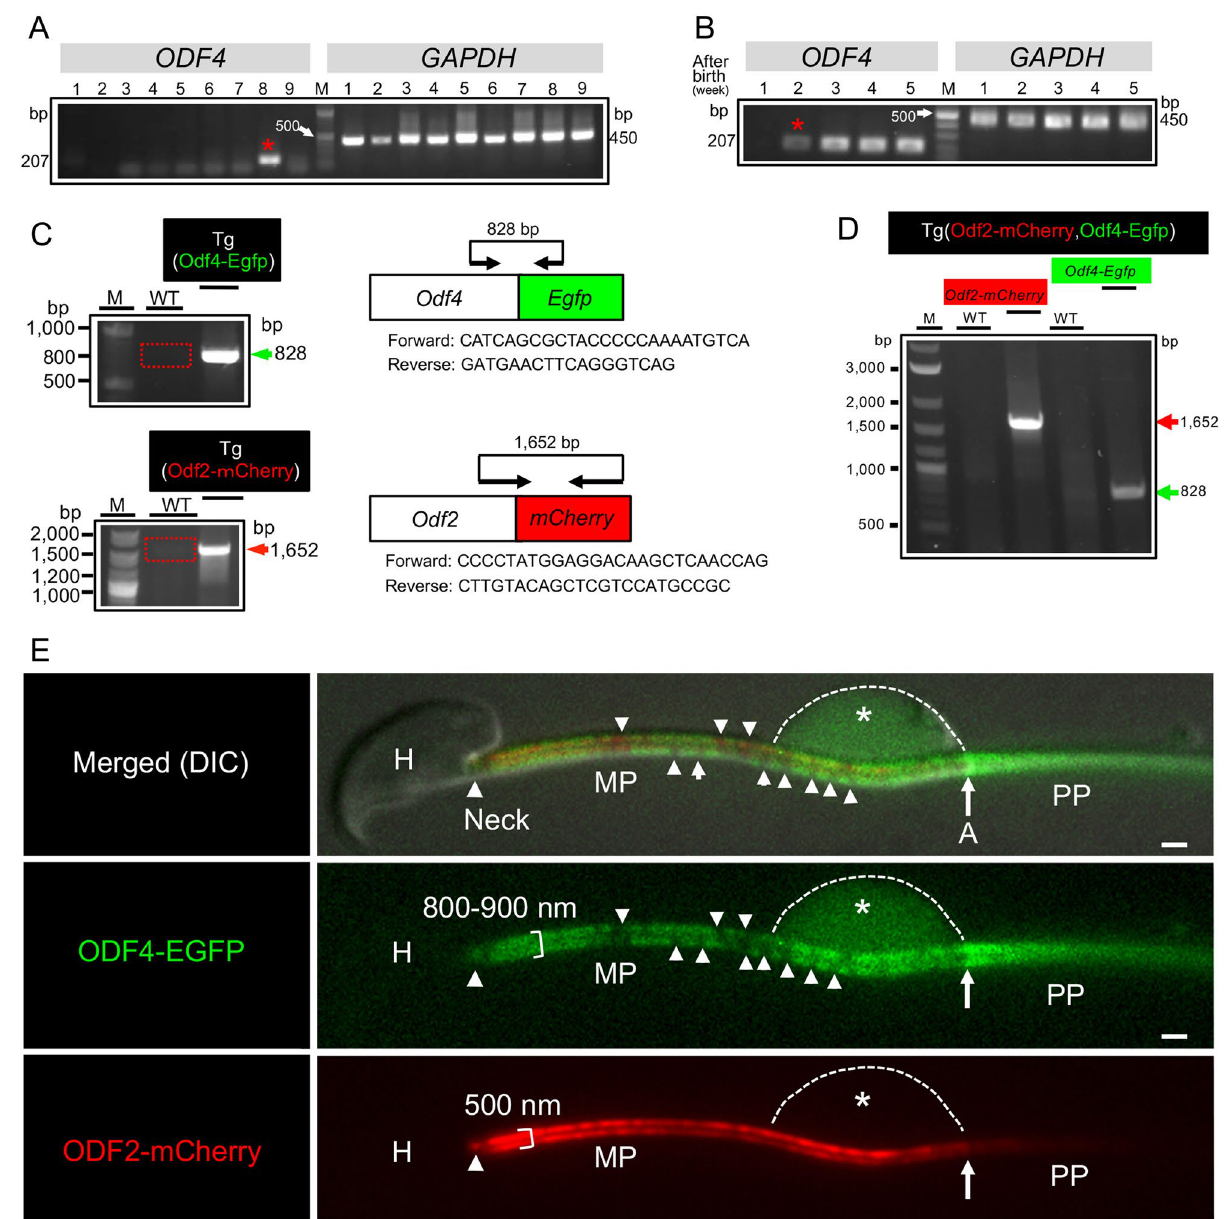
Figure 1. Odf4 and ODF4 expression, Tg generation, and localization difference between ODF4 and ODF2. ( A–D ) Cropped blots from the same gel. Original full-length images are shown in the supplementary Fig S1. ( A , B ) RT ‒ PCR. ( C , D ) Genomic PCR. ( A ) ODF4 : 207 base pairs (bp). GAPDH : 450 bp (Control). M, Marker proteins. ODF4 is expressed only in the testis ( * : lane 8). 1, Brain: 2, Heart: 3, Lung: 4, Liver: 5, Spleen: 6, Kidney: 7, Small intestine: 8, Testis: 9, Epididymis. ( B ) ODF4 is expressed first at 2 weeks ( * ) after birth. ( C ) (Top) Odf4-Egfp (828 base pairs (bp) and primers) contains inserted Tg (arrowhead) but not in the wild-type (WT: square). (Bottom) Generation of Tg(Odf2-mCherry) . Odf2-mCherry (1,652 bp and primers) was inserted in Tg (arrowhead) but not in the wild-type (WT: square). ( D ) Generation of double Tg(Odf2-mCherry,Odf4- Egfp). Green and red arrowheads indicate the inserted Odf4-Egfp (828 bp) and Odf2-mCherry (1,652 bp), respectively. ( E ) Localization comparison between ODF4 and ODF2. Fluorescence signals in double Tg(Odf2- mCherry,Odf4-Egfp) cauda spermatozoa. Merged (DIC): DIC image of merged ODF2-mCherry (red) and ODF4-GFP (green) signals. The width of the ODF4-EGFP green signal (800–900 nm) is larger than that of ODF2-mCherry (approximately 500 nm). The green signal is observed as a rather striped pattern in the midpiece reflecting mitochondrial arrangement (arrowheads), whereas it is linearly seen in the principal piece (PP). A green signal is observed in an expanded CD (*). Scale bar = 1